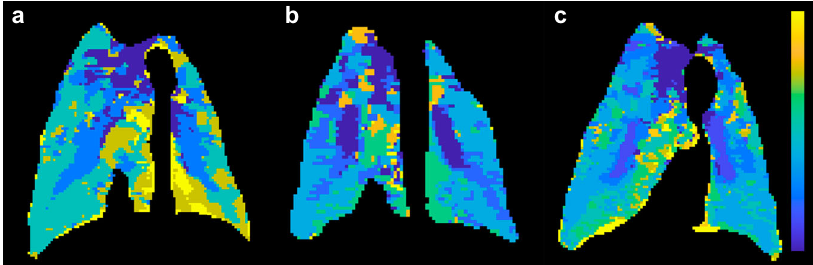
Fig. 6 Swine MRI perfusion. a Time-to-peak map of a model swine lung that has received ACE2 inhibition by MLN-4760 and low dose ANGII with the color lookup table set to maximum blue for pulmonary artery peak and yellow for aortic peak or later. b Control swine that has been sedated and performed MRI lung perfusion at approximately the same sedation time as the swine in a . c Treatment swine that has been given oral angiotensin receptor blocker and low molecular weight